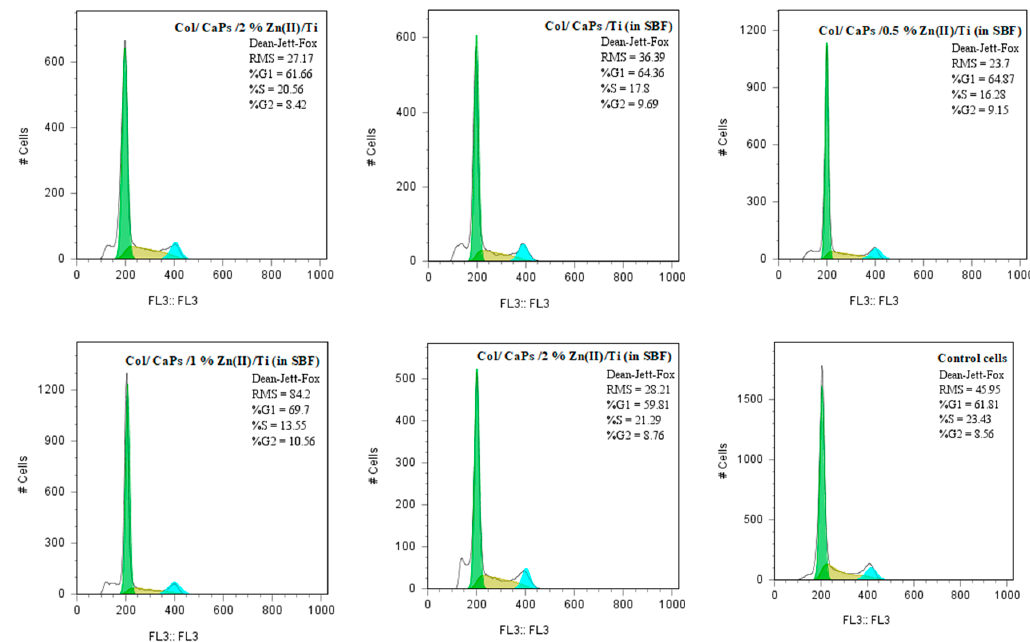
Figure 11. Cell cycle distribution of cells grown on Coll / Zn(II)-CPs thin films deposited on Ti by MAPLE.